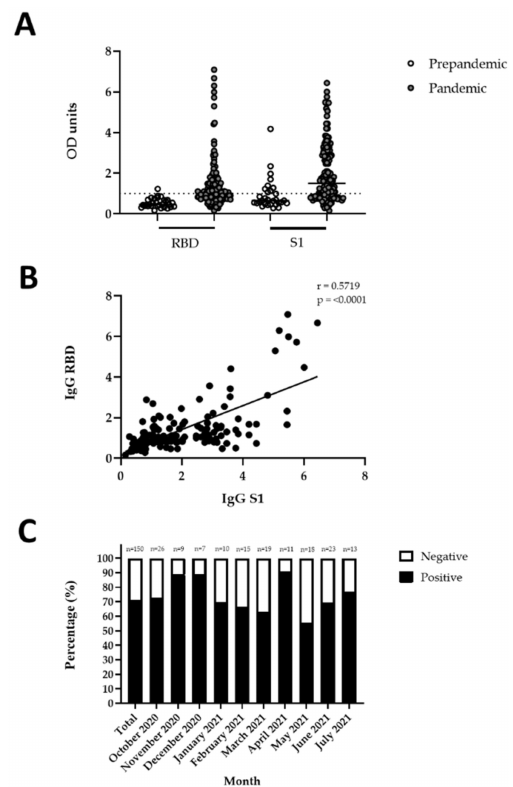
Figure 1. Seroprevalence of SARS-CoV-2 in patient cohort ( n = 150): ( A ) Detection of SARS-CoV-2 RBD- and S1-specific IgG antibodies in the study participants’ plasma. A total of thirty pre-pandemic patient samples [22] served as control. Results are represented by the OD units of each isotype, adjusted to the cut-off value of each individual plate and then normalized to the cut-off, which was set as one (indicated by the dotted line). The cut-off was determined by the mean OD + 2SD of the pre-pandemic samples; ( B ) The correlation between IgG responses to SARS-CoV-2 RBD and S1 antigens. Statistical analyses were performed using a non-parametric Spearman Rank correlation; ( C ) Timeline of SARS-CoV-2 IgG antibody detection per month over the course of the recruitment period from October 2020 to June 2021. Data is represented as a percentage (positive or negative) for the patient cohort. The total number of patients is indicated above the bars. A patient was considered to be positive for SARS-CoV-2 infection if either RBD or S1 responses were above our calculated cut-off values for the IgG